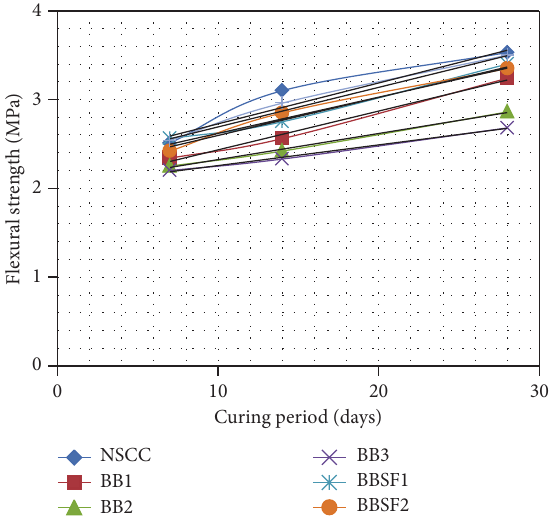
Figure 6: Comparison of the flexural strength.